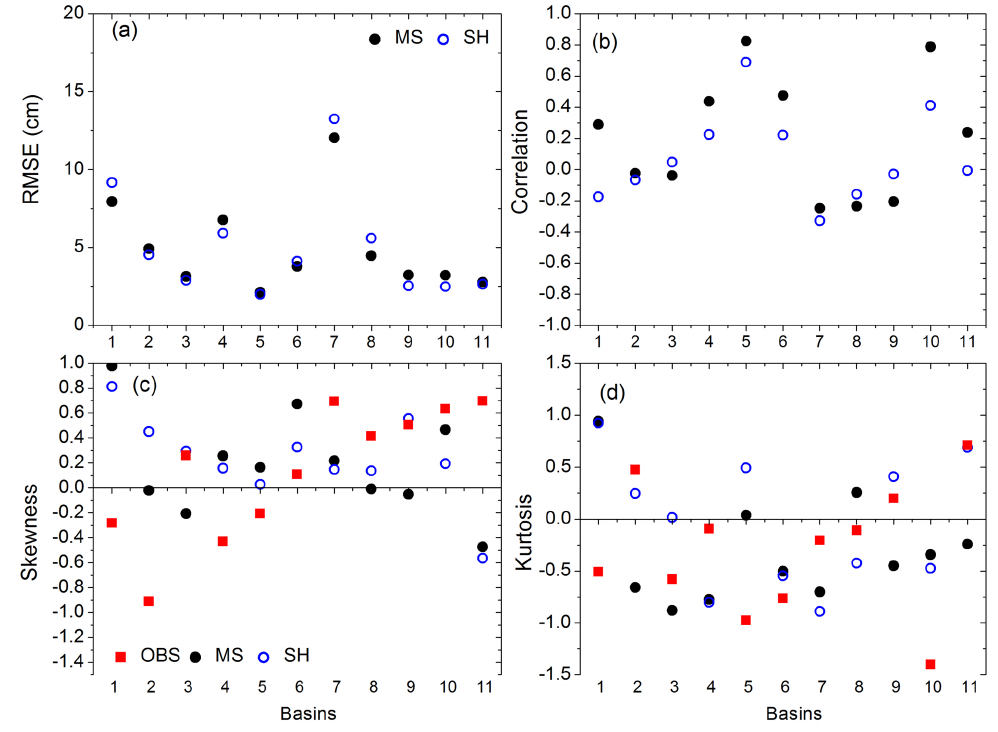
Figure 4. Basin-wide estimates of (a) RMSE, (b) correlation, (c) skewness, and (d)